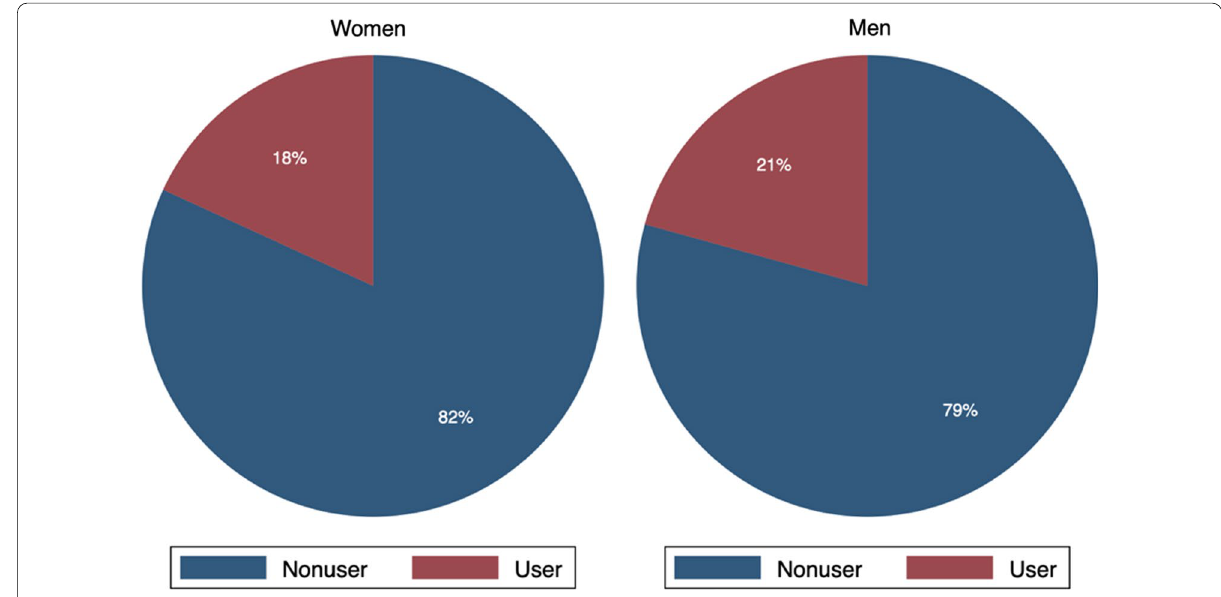
Fig. 1 Modern contraceptive use by